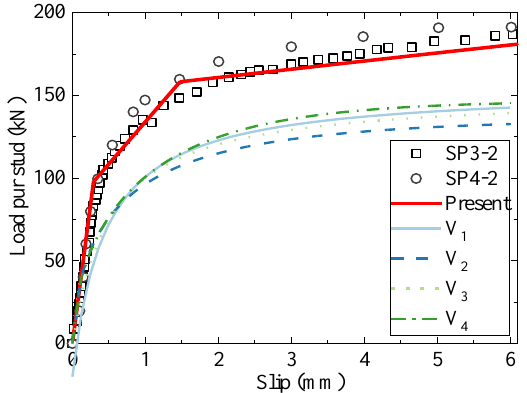
Figure 7. The comparison of load–slip curves between the test, empirical formulae, and the analytical method for SP3/4-2.